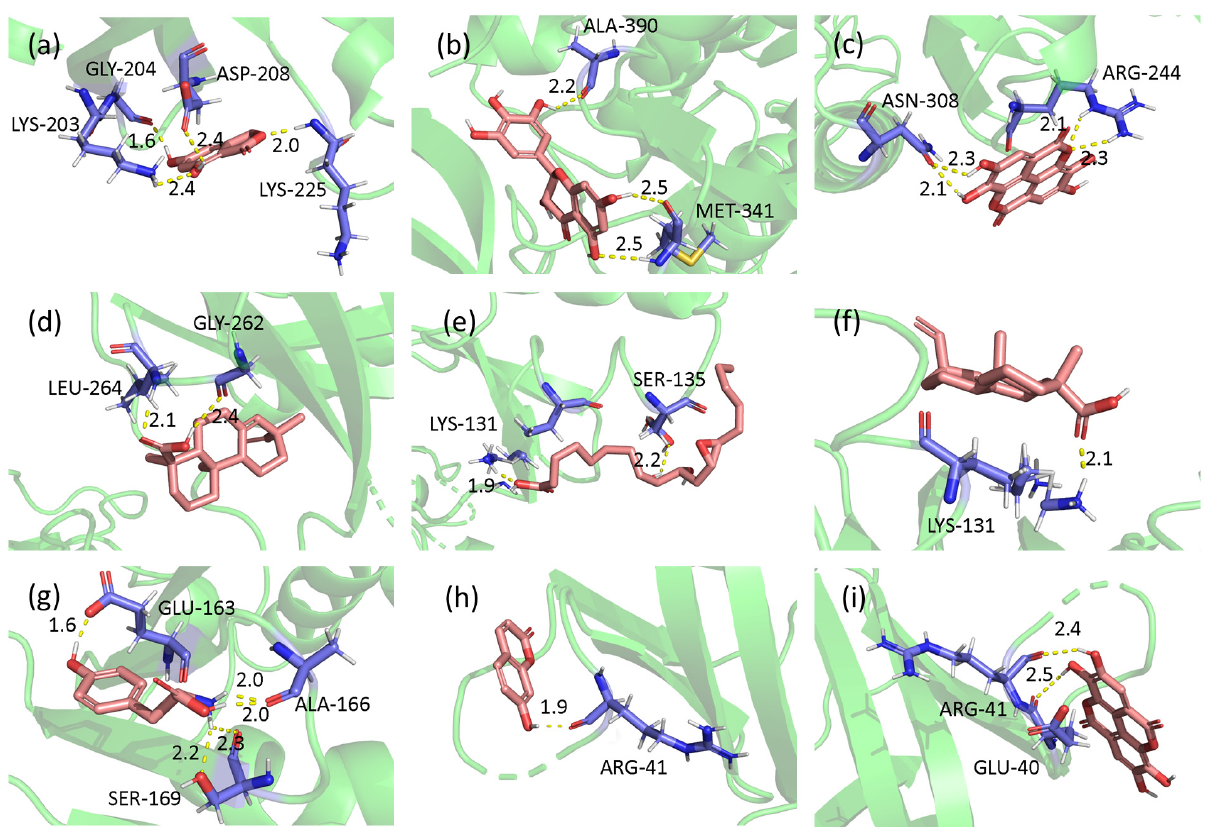
Figure 8. Docking conformation of five key target proteins and their combined components. ( a ) SRC to 5,7-Dihydroxy-1(3H)-isobenzofuranone. The binding energy is − 3.481. ( b ) SRC to dihydromyricetin. The binding energy is − 2.17. ( c ) SRC to ellagic acid. The binding energy is − 3.47. ( d ) TP53 to pimaric acid. The binding energy is − 5.83. ( e ) MAPK3 to 9,10-Dihydroxy-12,13-epoxyoctadecanoic acid. The binding energy is − 0.47. ( f ) MAPK3 to pimaric acid. The binding energy is − 5.47. ( g ) HSP90AA1 to L-tyrosine. The binding energy is − 3.76. ( h ) AKT1 to 7-hydroxycoumarin. The binding energy is − 5.28. ( i ) AKT1 to ellagic acid. The binding energy is − 5.17.